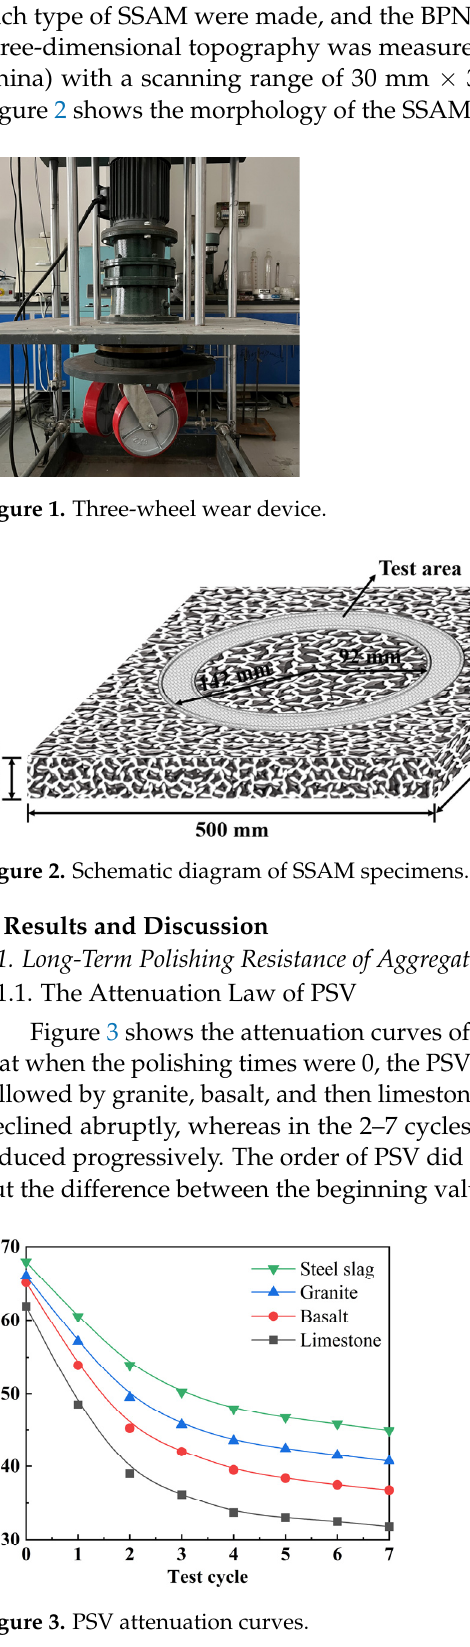
Figure 4. The change rate of PSV attenuation rate. 3.1.2. Changes in Micromorphology of Aggregate Surface The steel slag with the highest polishing resistance and the limestone with the lowest polishing resistance were chosen to be photographed by SEM, capturing images of the two without and after seven polishing cycles, as shown in Figure 5 and Figure 6, respec- tively. The SEM pictures show that the surface morphologies of steel slag and limestone are different, but both have rough surfaces. Both of them have complex texture features and large texture depth. After seven cycles of polishing, the surface morphologies of the two objects are noticeably distinct. The surface of limestone is predominantly flat, whereas the surface of steel slag retains excellent textural depth and features. Figure 5. ( a , b ) are the SEM images of the steel slag before and after 7 polishing cycles, respectively.